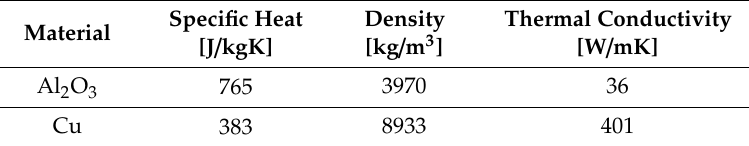
Table 2. Thermophysical characteristics of Al 2 O 3 and Cu nanoparticles.